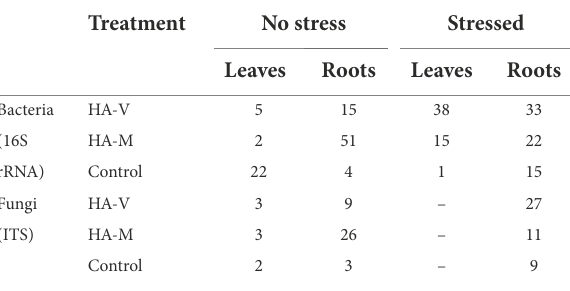
TABLE 3 Quantifications of differentially abundant (DA) taxa related to each treatment under the experimental conditions evaluated.